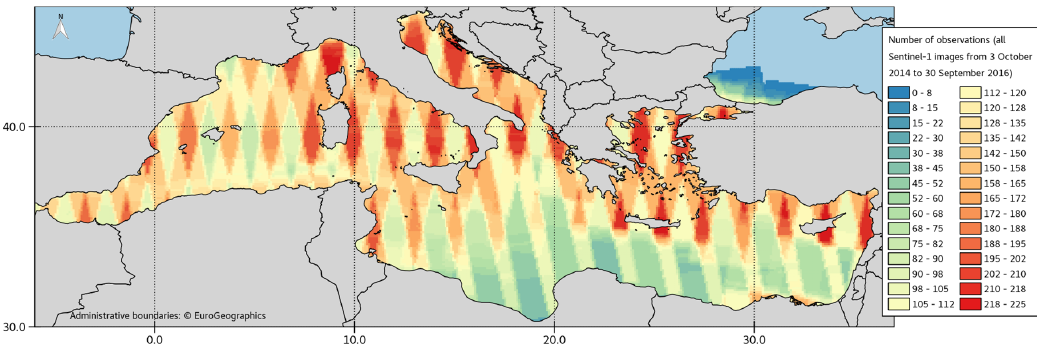
Figure 2. Number of observations for each geographic location used in the study (11,647 images, only Sentinel-1A). Calculated with a grid size of 0.1°.